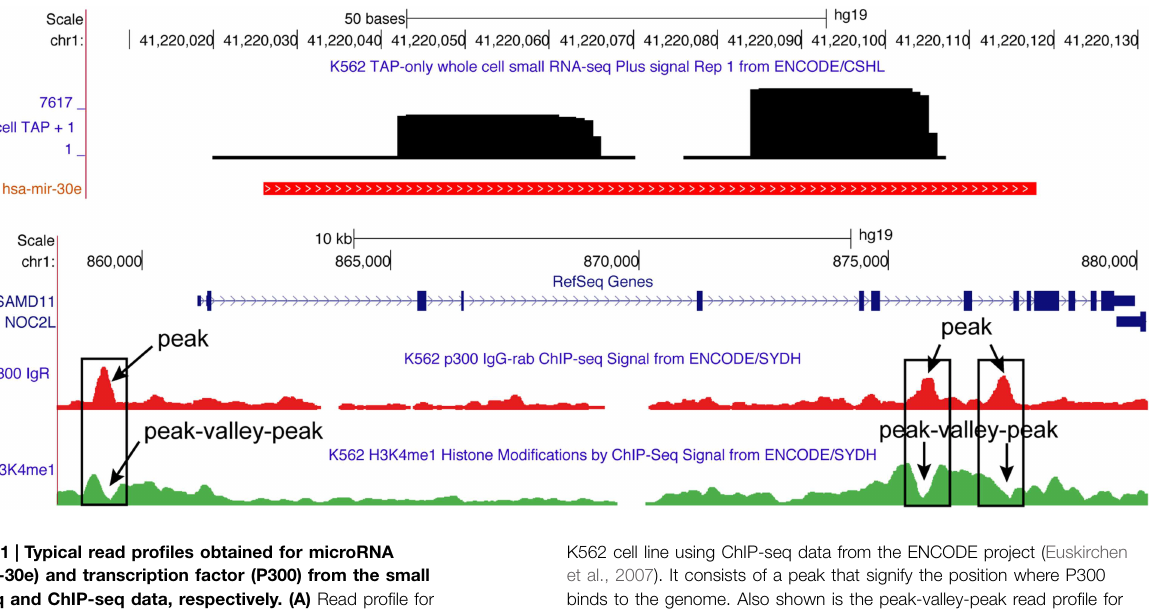
FIGURE 1 | Typical read profiles obtained for microRNA (has-mir-30e) and transcription factor (P300) from the small RNA-seq and ChIP-seq data, respectively. (A) Read profile for hsa-mir-30e is observed in K562 cell line using small RNA-seq data from the ENCODE project (Fejes-Toth et al., 2009). It consists of two read blocks corresponding to two arms (passenger and mature) of the microRNA. (B) Read profile for P300 transcription factor is observed in